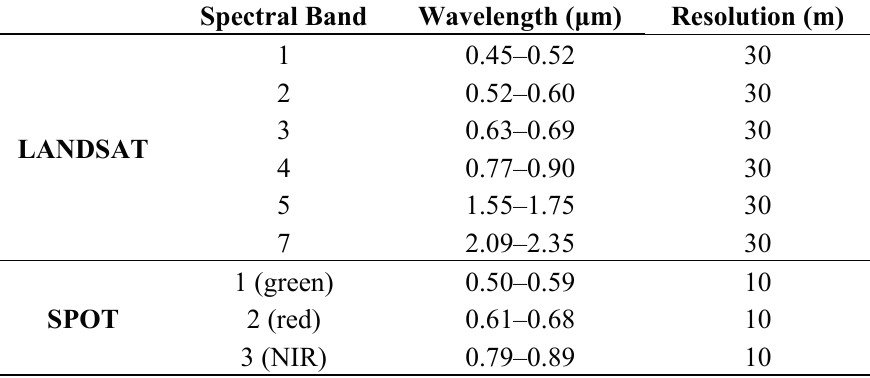
Table 1. Wavelengths and spatial resolution of satellite spectral bands